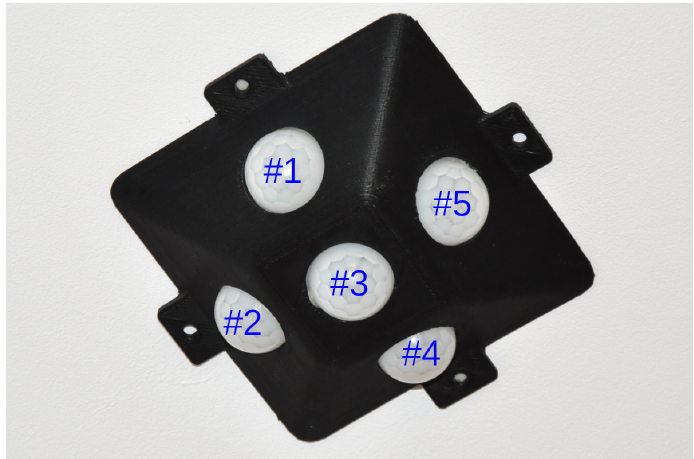
Figure 2. Sensor module with passive infrared (PIR)